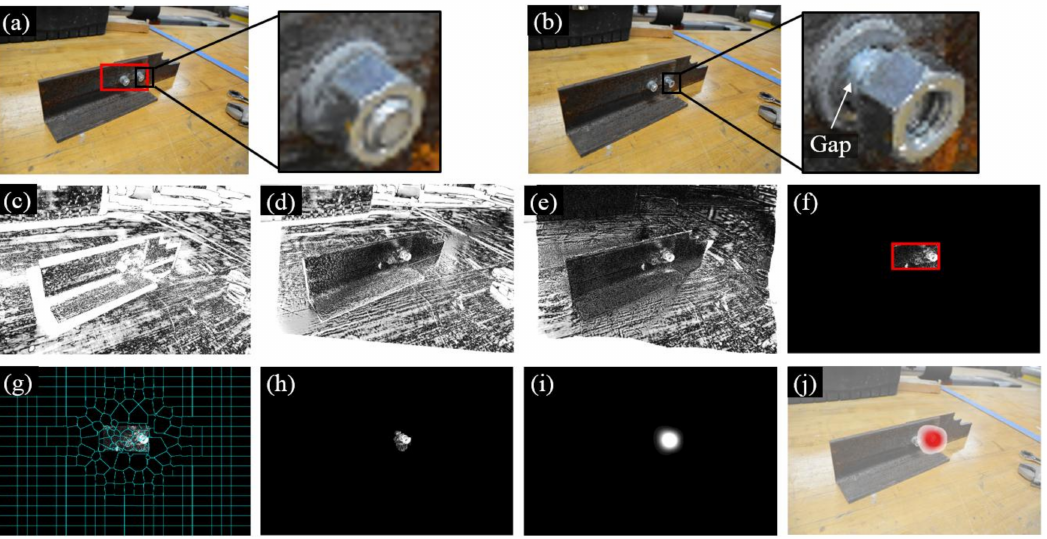
Figure 19. Experimental results under a gap caused by nut loosening: ( a ) Image 1 taken during the first inspection period; ( b ) Image 2 taken during the second inspection period; ( c ) initial errors between Image 1 and 2; ( d ) errors after feature-based image registration; ( e ) errors after intensity-based image registration; ( f ) windowing applied to the registration errors; ( g ) registration errors segmented into superpixels; ( h ) feature enhancement; ( i ) Gaussian filtering; and ( j ) result